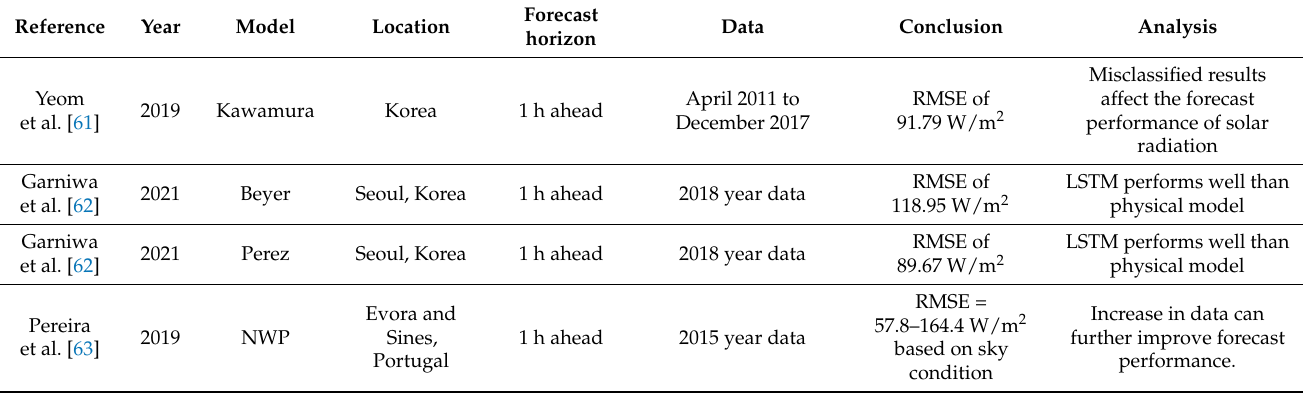
Table 4. Summary of Physical